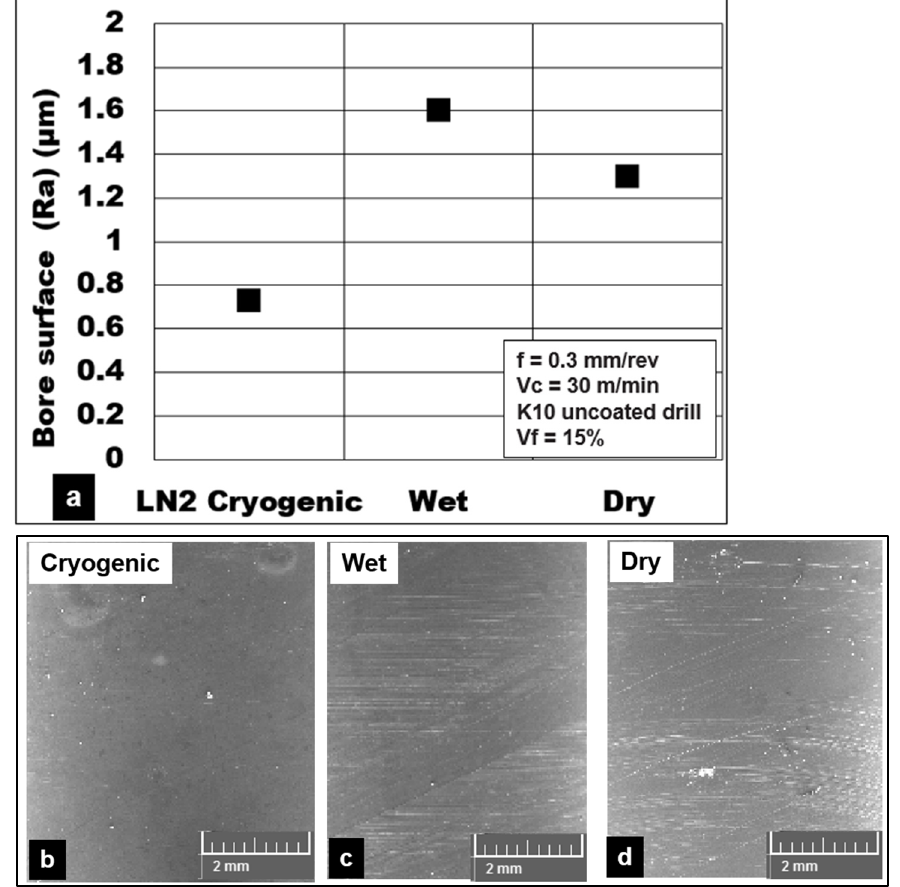
Figure 9. ( a ) Influence of coolant on average roughness during machining of Mg-9Al-1.4Zn-15% hollow Al 2 O 3 foam. SEM images showing the bore surface under ( b ) cryogenic, ( c ) wet and ( d ) dry conditions.